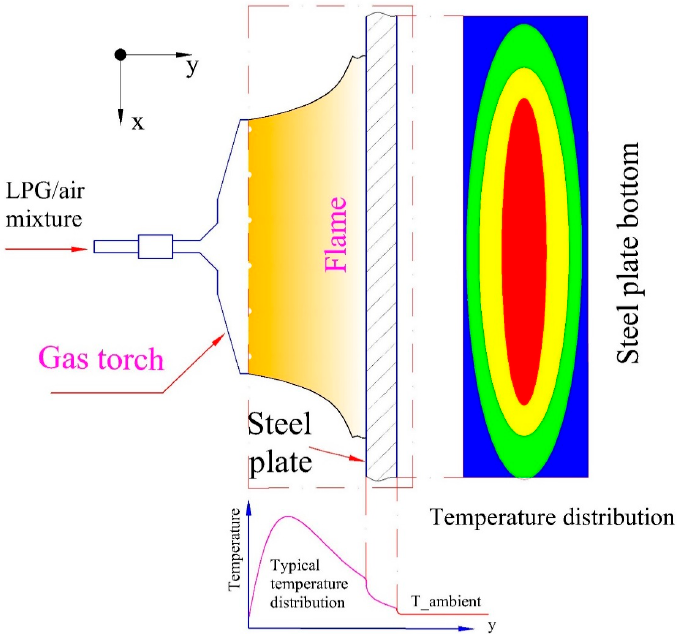
Figure 1. Schematic diagram of steel preheating process using LPG/air mixture, and multiple flame jets, as well as typical expected temperature distributions of the flame jet and the steel plate.